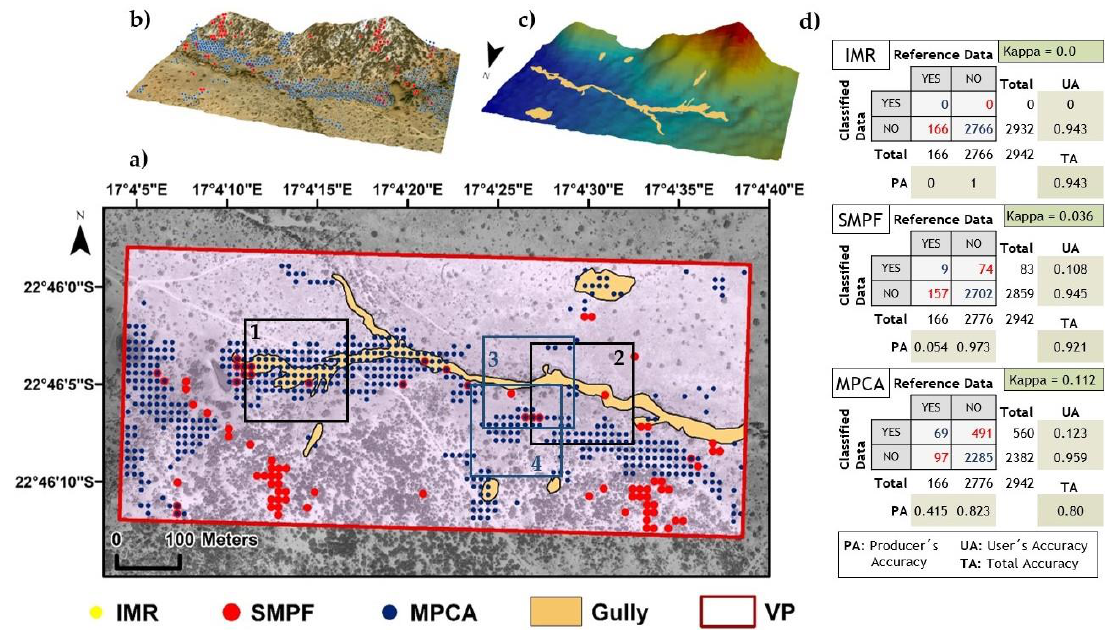
Figure 9. ( a ) Results of the different gully classification methods for VP1. The black frames (1 and 2) is the sub-area selected to perform the zonal analysis of terrain and gully characteristics detailed in Figure 10. The blue squares are those extents of the MPCA kernels studied in Figure 11. ( b,c ) 3D scenes of gully extents and results of the classification. ( d ) Resultant confusion matrices for IMR, SMPF, and MPCA, and their correspondent Kappa